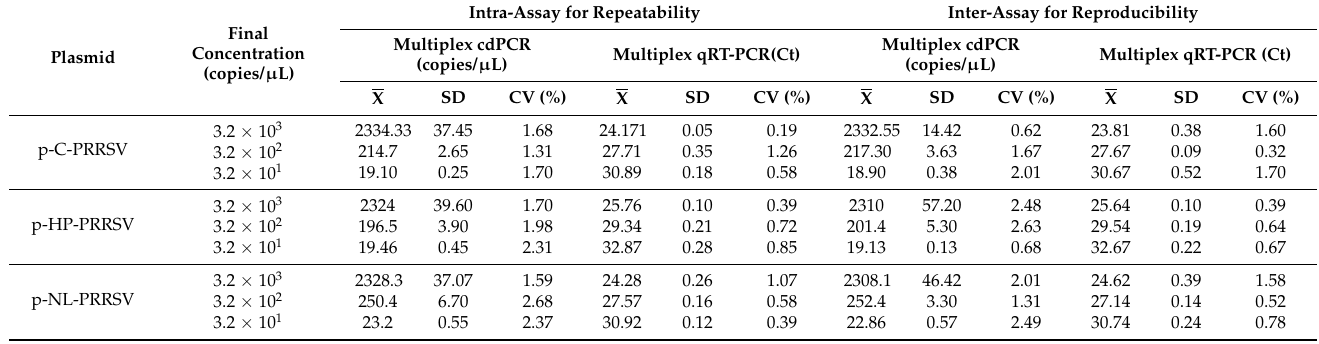
Table 3. Repeatability and reproducibility analysis of the multiplex cdRT-PCR and the multiplex qRT-PCR.